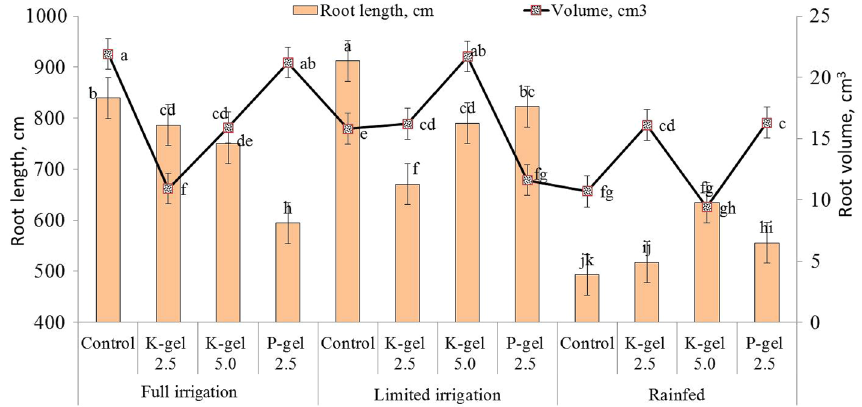
Figure 3. Combined effects of hydrogels and irrigation regimes on root length and volume of wheat in 2018–19. Bars indicate standard error of